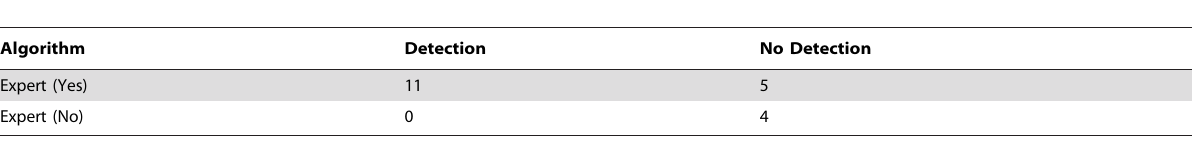
Table 3. Comparison of expert detection and prediction by the algorithm.